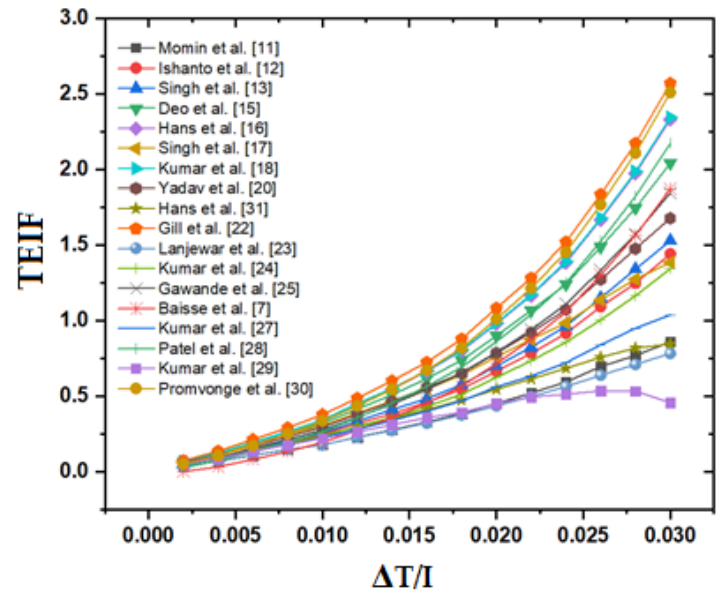
Figure 7. TEIF of the roughened duct with respect to ∆ T/I.